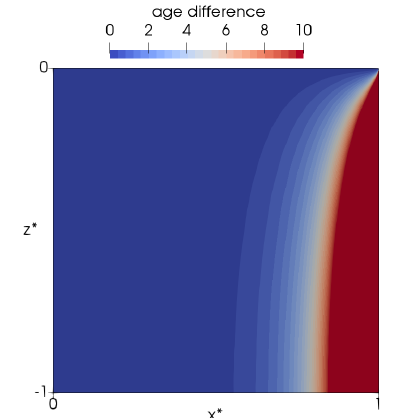
Figure 11. Difference between the non-consistent age and the correct one for ( Pe x , Pe z ) = ( 10,10 ) . Dimensionless variables similar to those of Figure 10 are represented. On the departure boundary, the age difference is infinite, but the colour is saturated at a value of 10.